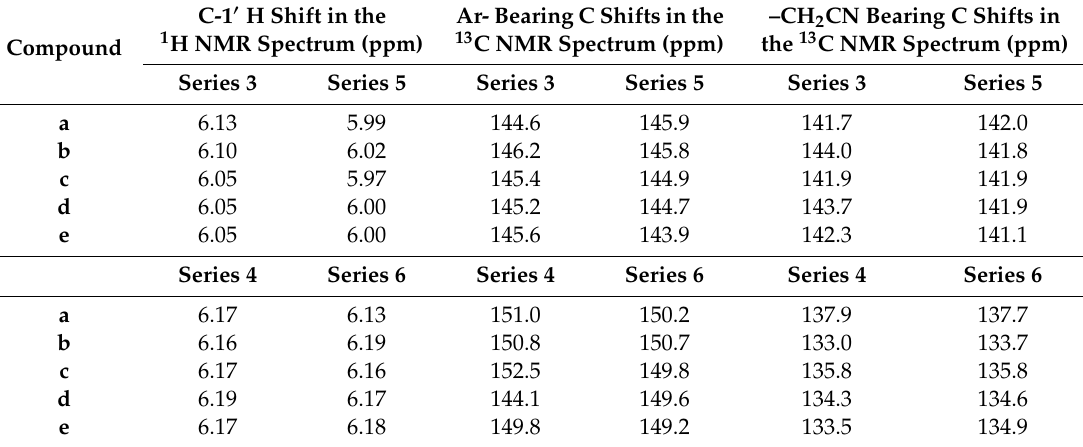
Table 1. Chemical shift values of the anomeric protons in the 1 H NMR spectra and chemical shift values of the Ar- and CH 2 CN bearing carbons of the pyrazole ring in the 13 C NMR spectra of the isomeric pyrazolyl nucleosides 3a – e , 4a – e , 5a – e , and 6a – e in CDCl 3 on a Bruker Avance 300 spectrometer.